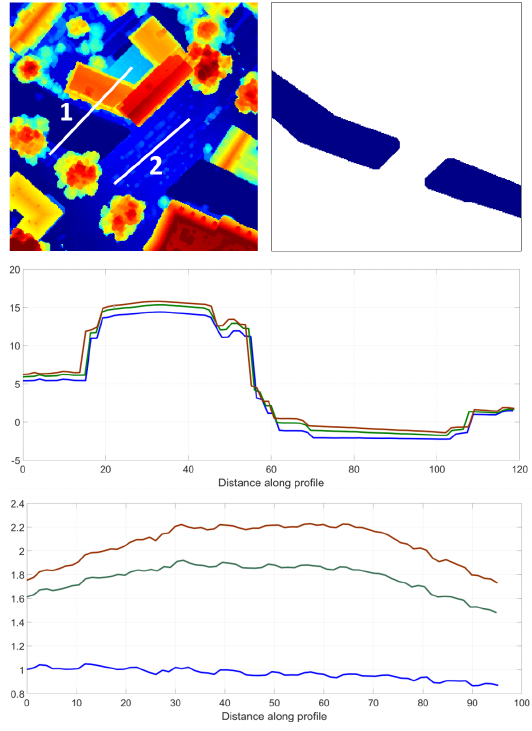
Figure 6. OSM-affected DSM − DTM including a river-profile line (1) and a bridge profile line (2) (top left), binary mask for unreliable areas (top right). River profiles (middle),bridge profiles (bottom) [L 1 spline (blue line), L 2 spline (green line), Gridfit (brown line)].